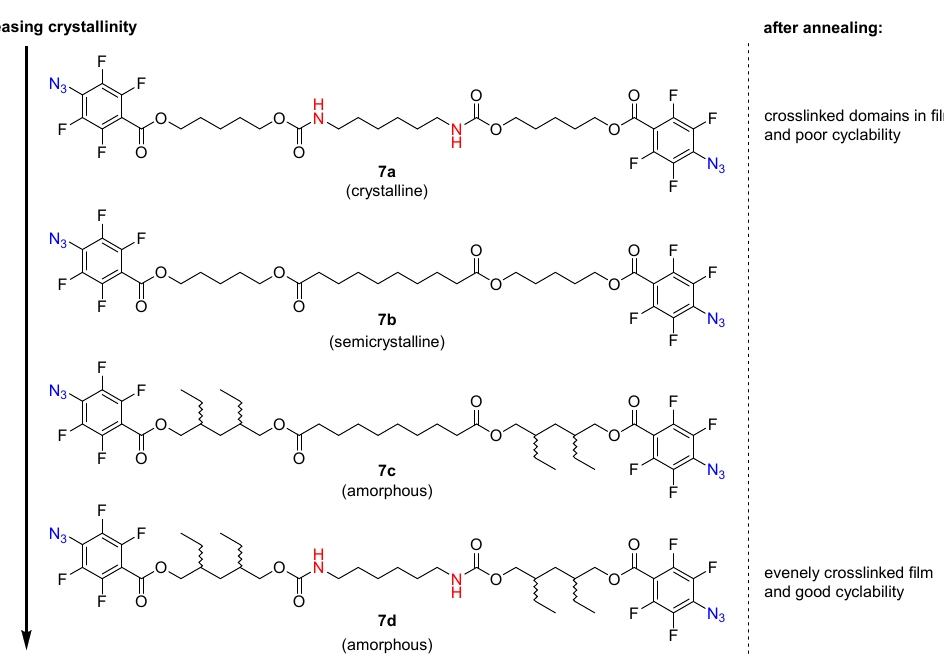
Figure 7. Influence of crosslinker morphology on film morphology.